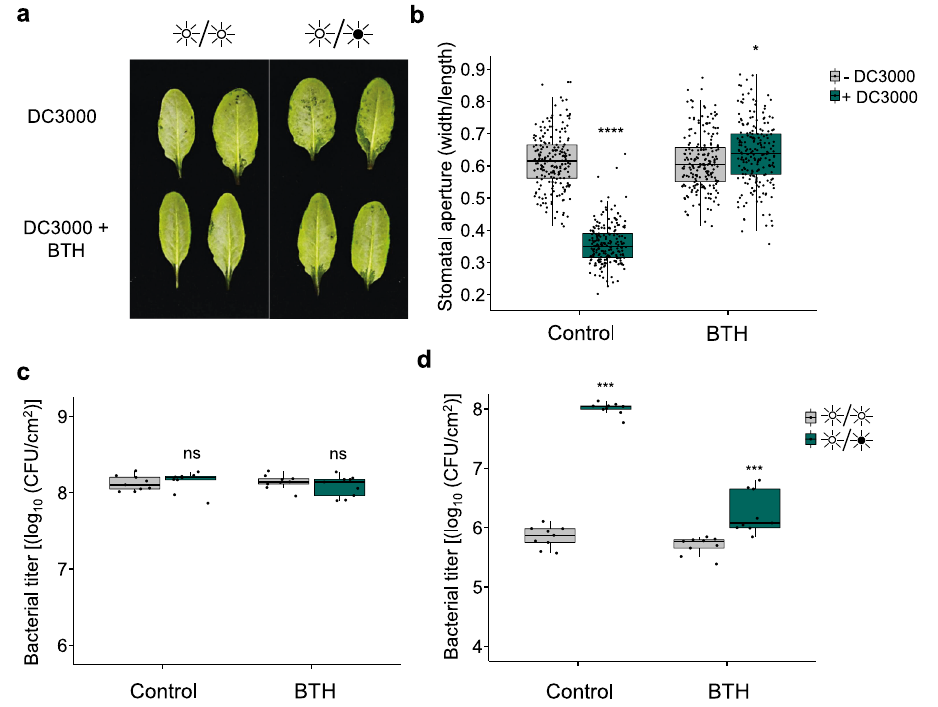
Fig. 4 | BTH provides protection against bacterial induction of water-soaking. a Water-soakingphenotypesinWT Arabidopsis in fi ltratedwithDMSO(0.1%)orBTH (50 μ M) prior to syringe-in fi ltration with Pst DC3000 (1×10 8 CFU/ml) 24h later. Photos were taken 24h post-infection. b Stomatal aperture in WT Arabidopsis treated as in a and in which MgCl2 (10mM; − DC3000) or Pst (1×10 8 CFU/ml; +DC3000) was syringe- fi ltrated. Plants were left under light/dark conditions and stomatal apertures assessed at 24h post in fi ltration (hpi) ( n =202 stomata for all conditions). c Bacterial titers from plants treated in a measured 24 hpi ( n =3 bio- logically independent replicates). d Bacterial titers from Arabidopsis leaves that were in fi ltrated with DMSO (0.1%) or BTH (50 μ M) 24h prior to being challenged